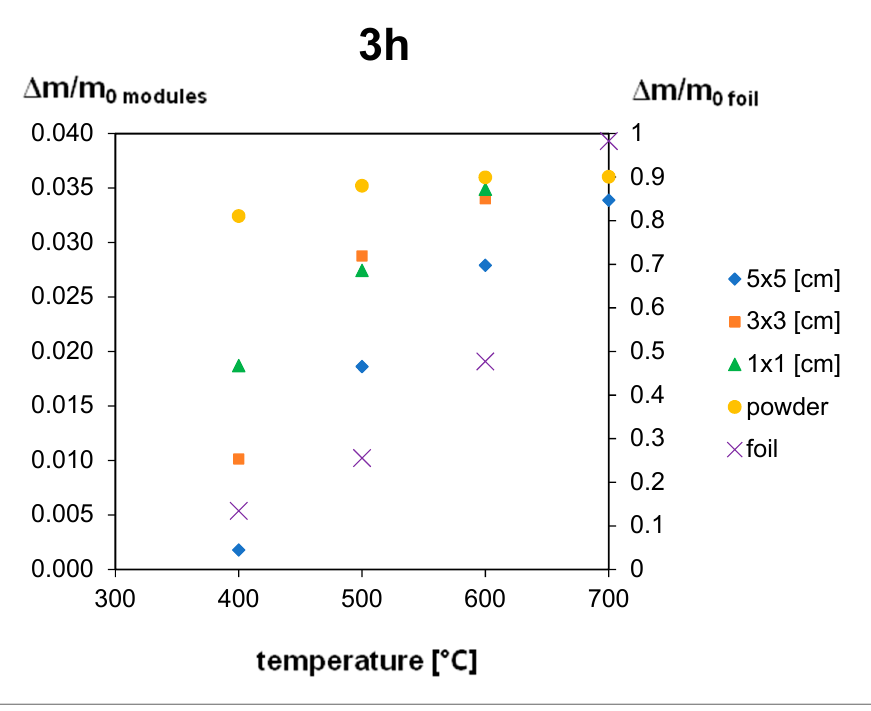
Figure 7. Results of the thermal treatment of module pieces and EVA foil for 5 h. The EVA foil samples were thermally decomposed after 3 h at a temperature of 700 °C and after 5 h at 600 °C. For the samples of the module pieces, despite the decomposition time, the temperature had to reach 500 °C to complete the decomposition of EVA. This means that during the module treatment the increase of temperature to 500 °C is obligatory, and time elongation is not efficient (Figures 5–7), but for powder gradation, the temperature can be decreased below 500 °C for energy savings.